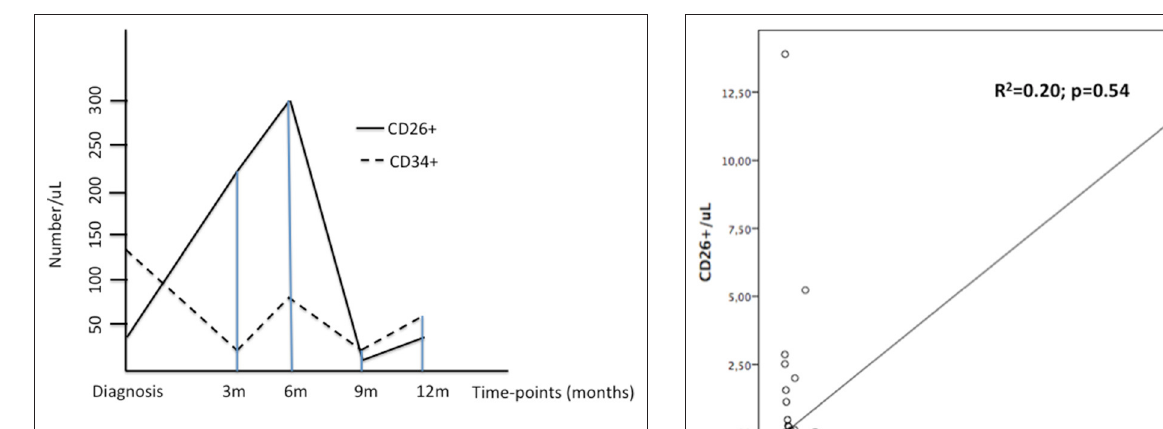
FIGURE 1 | The Figure represents the median values of CD34 + /CD38- and CD34 + /CD26 + progenitors at diagnosis and during treatment with imatinib; for a better understanding, the values of CD26 + cells have been multiplied by ten.